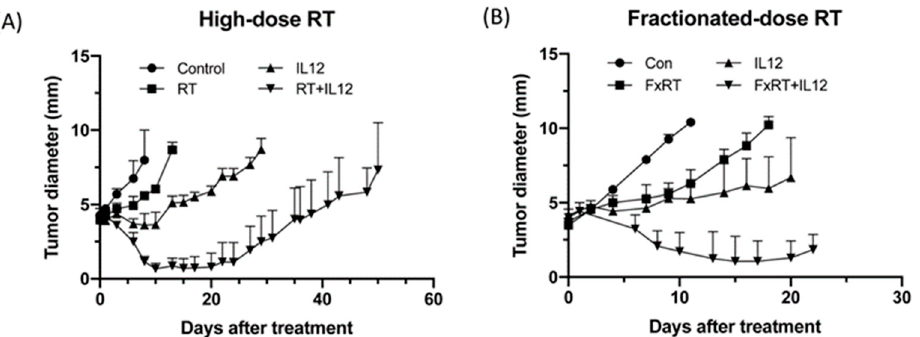
Figure 1. Combining r adiation with local IL-12 therapy shrank TRAMP-C1 tumors and retarded the tumor growth. TRAMP-C1 tumors were irradiated when tumor reached the suitable size. Normal saline or Ad-sc-IL-12 adenovirus diluted in normal saline was injected after irradiation with ( A ) high-dose RT (25 Gy) and ( B ) fractionated-dose RT (8.9 Gy per fraction with five times). Each group contained four mice and the experiment was repeated twice independently.